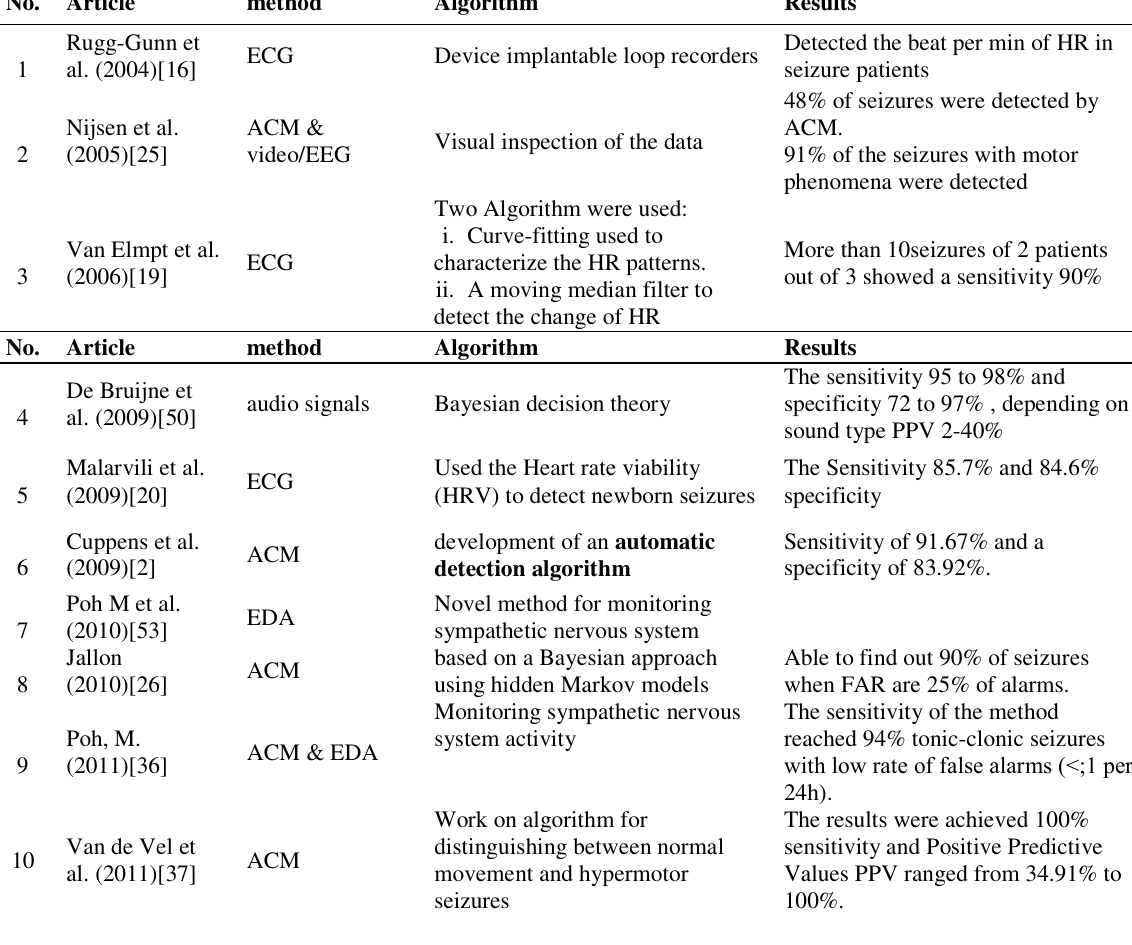
The review of different method, Algorithm and results for the detection of seizures. ECG= Electrocardiography , EEG= Electroencephalography , HRV=Heart Rate Viability, ACM= Accelerometer , KNN= K-Near Neighbors, EDA= Electro-dermal activity, EMG= Electromyography, SpO2=Arterial Oxygenation , TEMP= Temperature, NoC=Network on Chip , FAR=False Alarm Rate , FDR= False Discovery Rate, FP= False Positive,